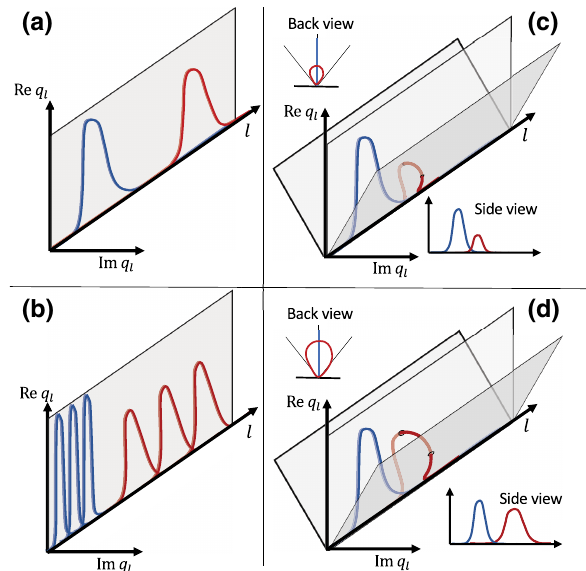
FIG. 4. A short summary of teleportation by size, discussing different systems, different patterns of operator growth, and the consequence of each growth pattern for signal transmission. (a) Operator growth, late time, most quantum systems: teleports one qubit through state-transfer mechanism; sgn( g ) independent; infi- nite temperature. (b) Operator growth, intermediate time: chaotic spin chains, random circuits; teleports many qubits through state- transfer mechanism; sgn( g ) independent; infinite temperature. (c) Size winding (damped), low temperature: teleports through state- transfer mechanism; weak sgn( g ) dependence; works weakly for “operator transfer.” (d) Perfect size winding (not damped), low temperature: could teleport through state-transfer mechanism; strong sgn( g ) dependence but limited fidelity; works perfectly for “operator transfer” slightly before scrambling time; strong signature of a geometrical wormhole . Blue, initial operator-size distribution; red, winding size distribution of the time-evolved